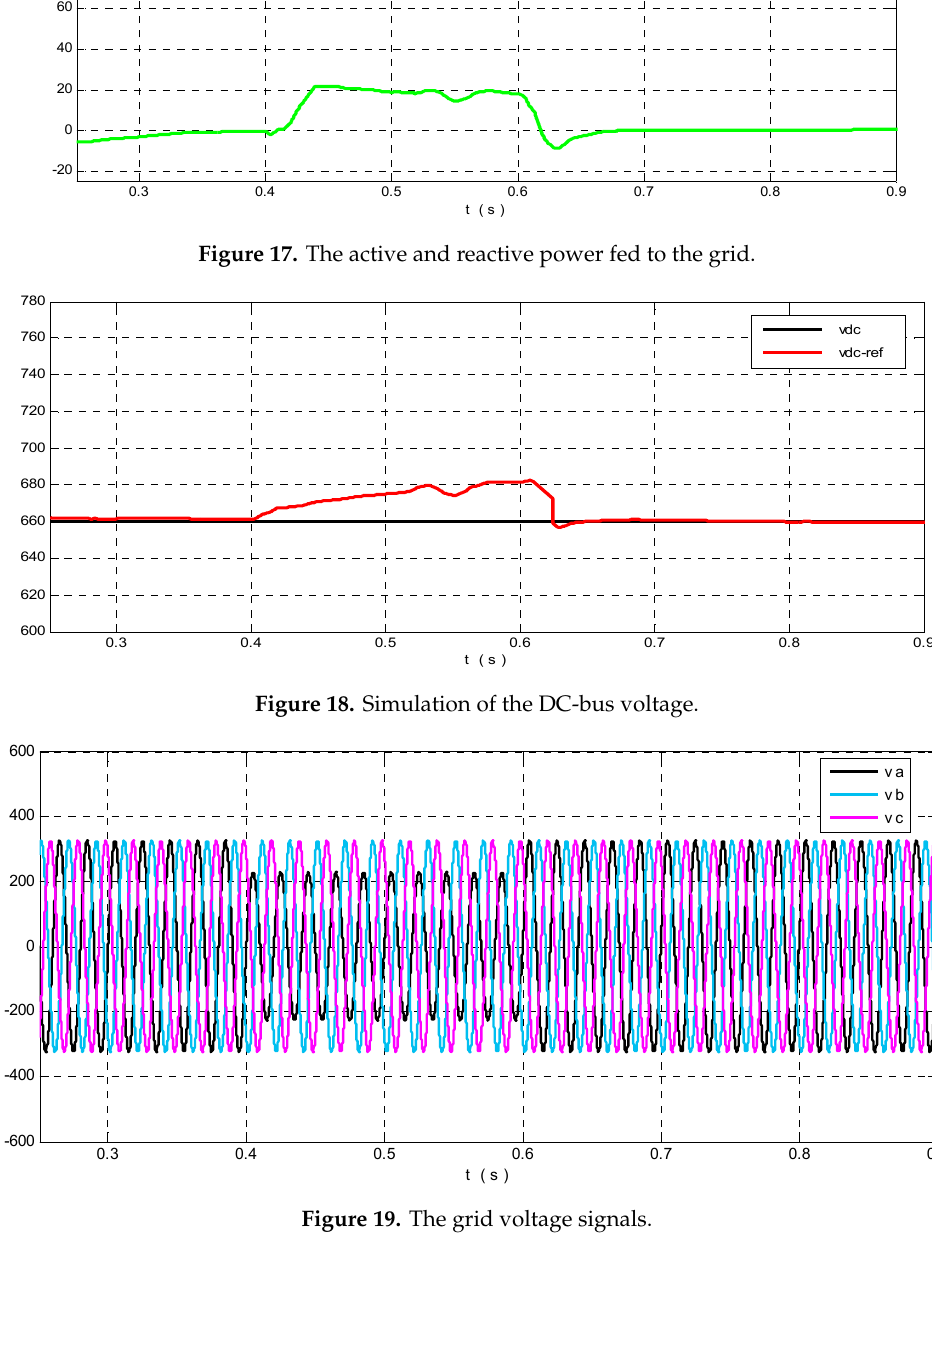
Figure 20. Voltage and current signals (phase a).